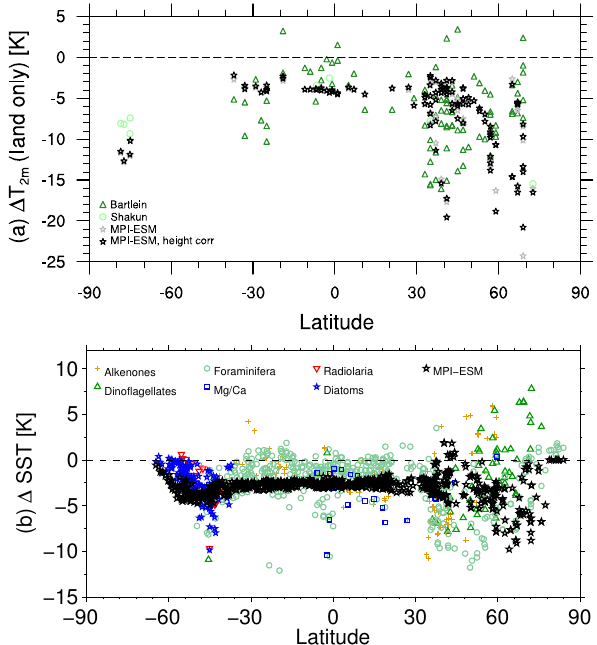
Figure 2. Comparison of the temperature differences within the model to reconstructed temperature differences at the proxy sites (LGMref – piCTL). (a) Land-based temperature differences from Bartlein et al. (2011) (dark-green triangles), additional points from the compilation by Shakun et al. (2012) provided in the online sup- porting material of Schmittner et al. (2011) (light-green circles) and simulated surface temperature differences (without height correc- tion: grey stars, with height correction: black stars). (b) SST differ- ences from MARGO (coloured symbols) and simulated SST differ- ences (black stars).